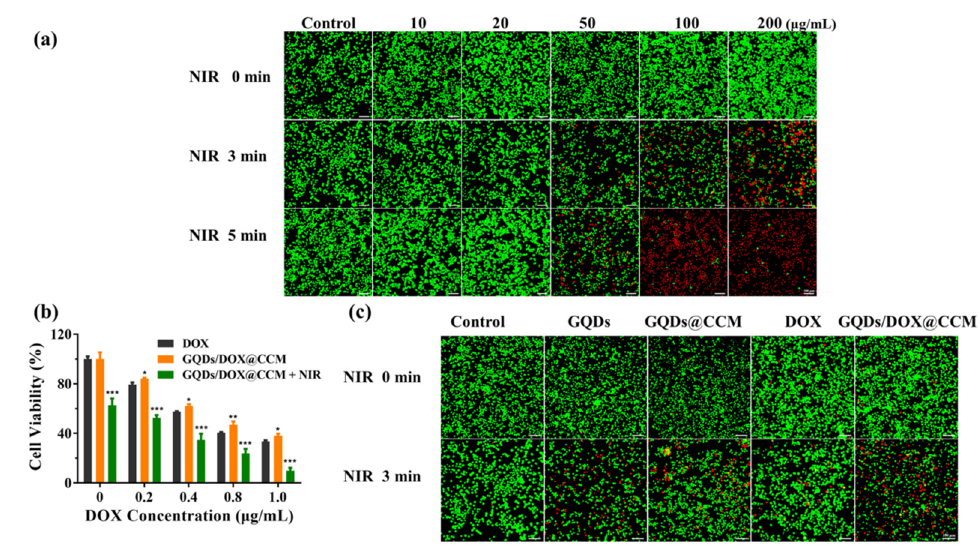
Figure 8. Antitumor efficacy in vitro. ( a ) The cytotoxicity of BV2 cells treated with different concentra- tions of GQDs for 4 h with NIR laser irradiation (808 nm, 1.44 W/cm 2 ). Scale bar = 10 µ m. ( b ) Relative BV2 cells viability after treatment with different concentrations of DOX, GQDs/DOX@CCM, and GQDs/DOX@CCM (NIR) for 24 h. ( c ) Calcein-AM/PI cell staining of BV2 cells subjected to different treatments. Scale bar = 10 µ m. The differences among groups were determined by a one-way ANOVA analysis followed by the Tukey’s post-test: * p <0.05, ** p <0.01, *** p < 0.001.